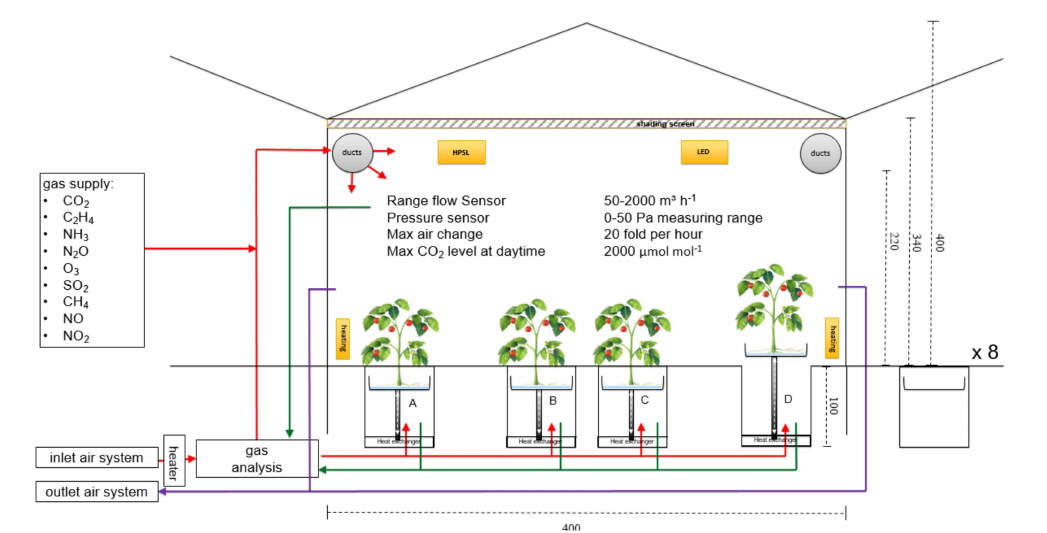
Figure 1. Simplified sketch of the experimental gas-exchange facility (not on scale) of one of eight cabins with four troughs (A, B, C, in separate root zone measurement mode; D in open mode for cooling the shoot environment). Red lines denote gas-supply, green lines denote gas sampling, and violet lines is the outlet air. For supplementary lighting 12 high-pressure sodium lamps (HPSL) or multi-channel LED lamps can be mounted (six lamps of each side of each greenhouse compartment). All fluxes are measured with continuous flux-meters. Irrigation and fertigation are done automatically and can be adjusted for each trough independently (not in the